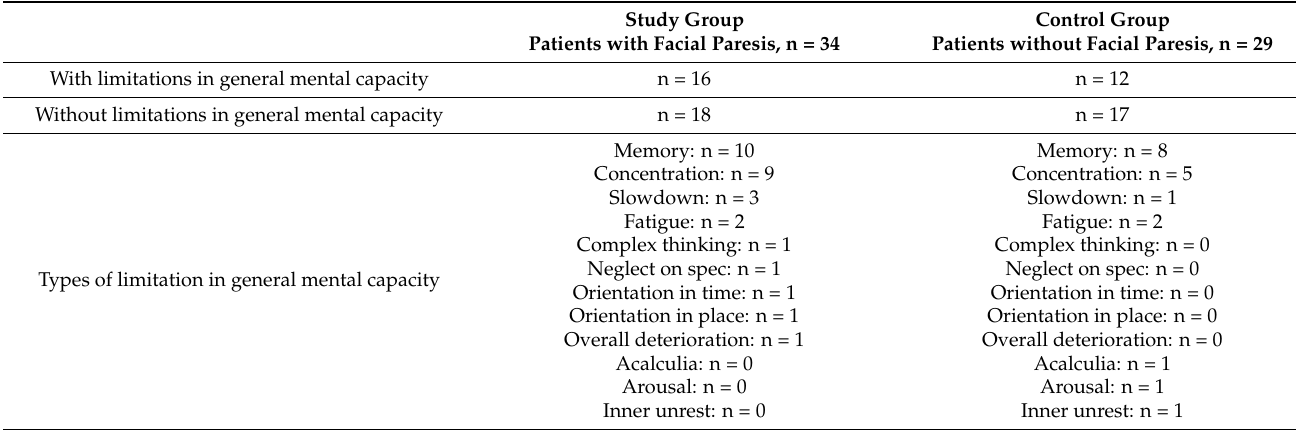
Table A5. Summary of facial paresis and general mental capacity information.